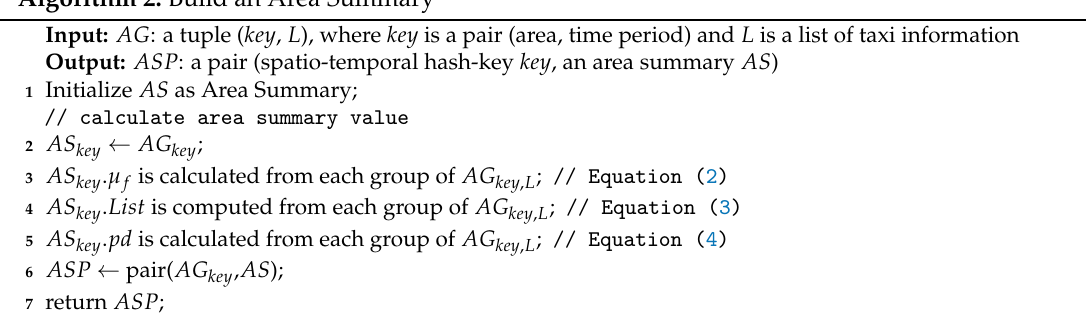
Algorithm 2: Build an Area